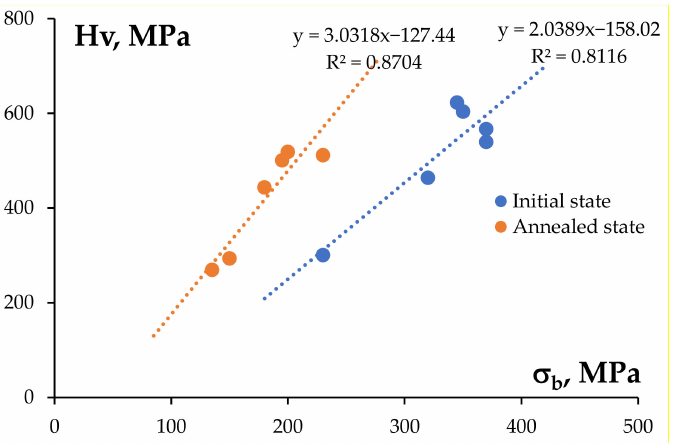
Figure 8. The dependencies H V ( σ b ) for the bimetallic wires in the non-annealed state and after annealing at 450 ◦ C (30